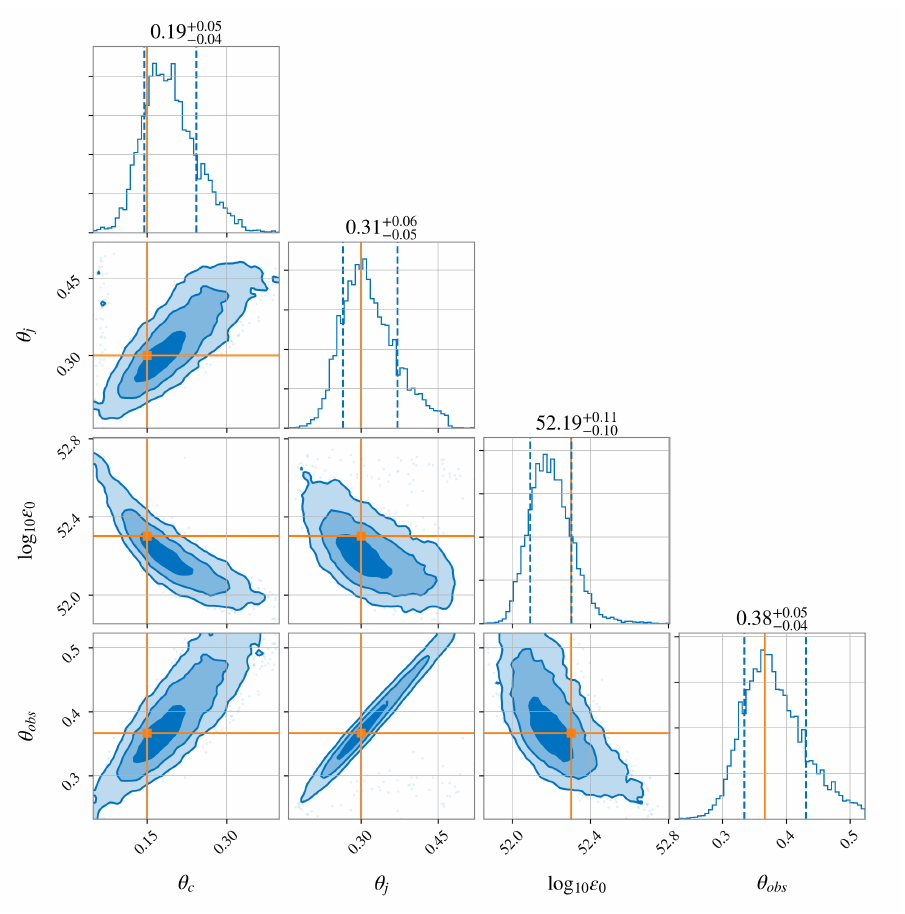
Figure 4. Probability density distribution of parameters in a power-law structured jet model. Orange vertical lines indicate the injected values from which the input data was